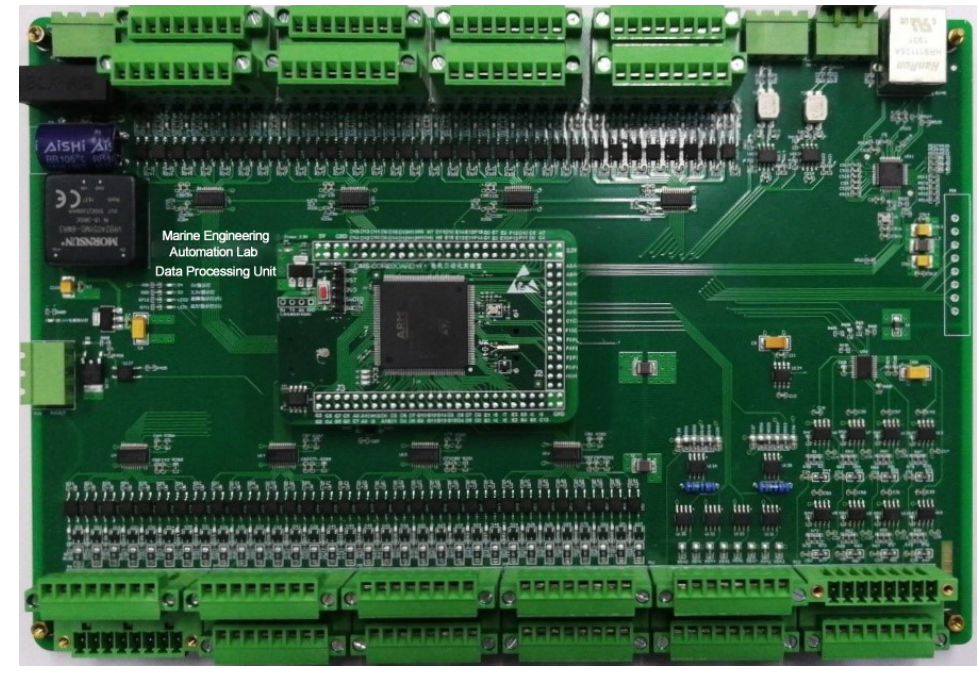
Figure 8. Data Processing Unit. Table 2. DPU upgrade testing